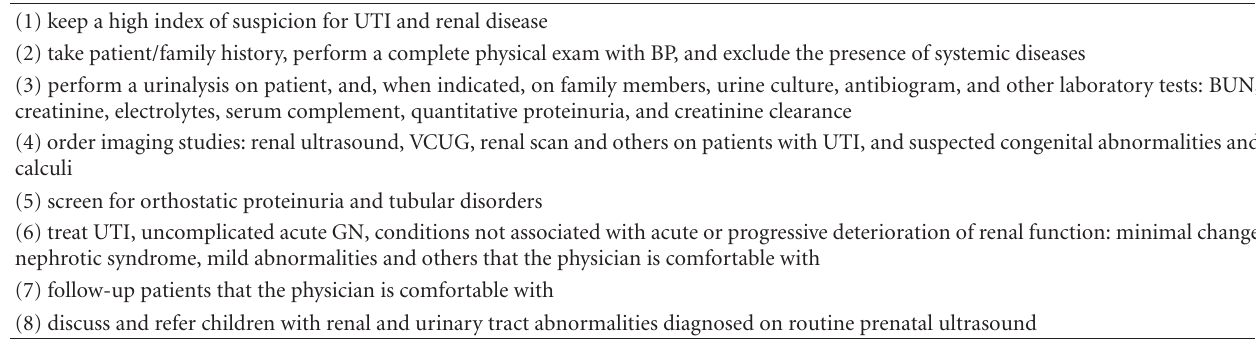
Table 1: Role of the pediatrician in the management of the child with renal disease [1].